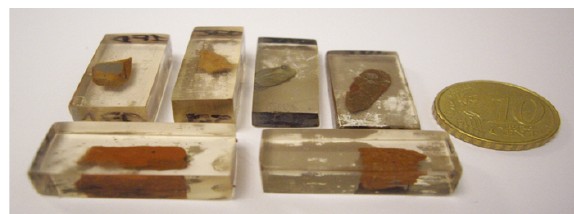
Figure 5: Bits taken from the ceramic fragments included in the test probes prepared for the Scanning Electron